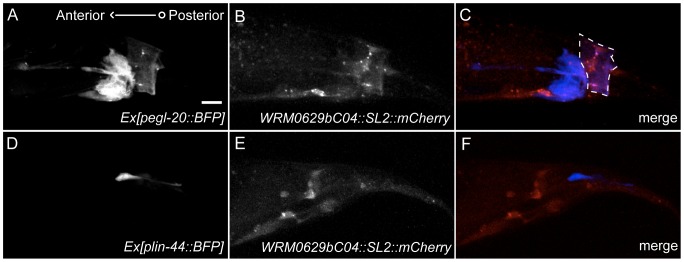
The expression pattern of mtm-6 overlaps with the expression pattern of egl-20.When the expression pattern of Ex[Pegl-20::BFP] (A) is compared with the expression pattern of Ex[WRM0629bC04::GFP::SL2::mCherry] (B) there is overlap within the anal depressor muscle (C). When the expression pattern of Ex[Plin-44::BFP] (D) is compared with the expression pattern of Ex[WRM0629bC04::GFP::SL2::mCh] (E) there is no overlap in the merge (F). Scale bar is 10 µm. Dashed line highlights the region of the anal depressor muscle.